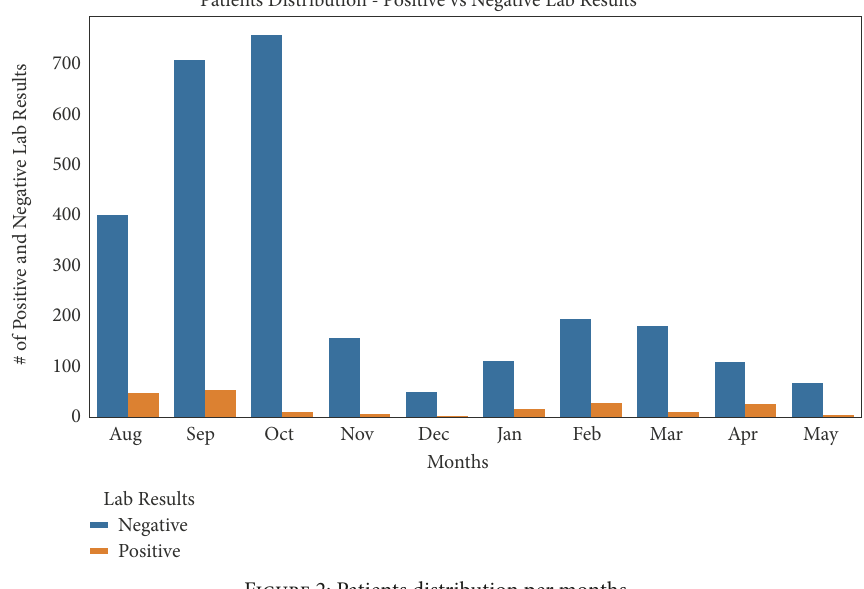
Figure 2: Patients distribution per months.